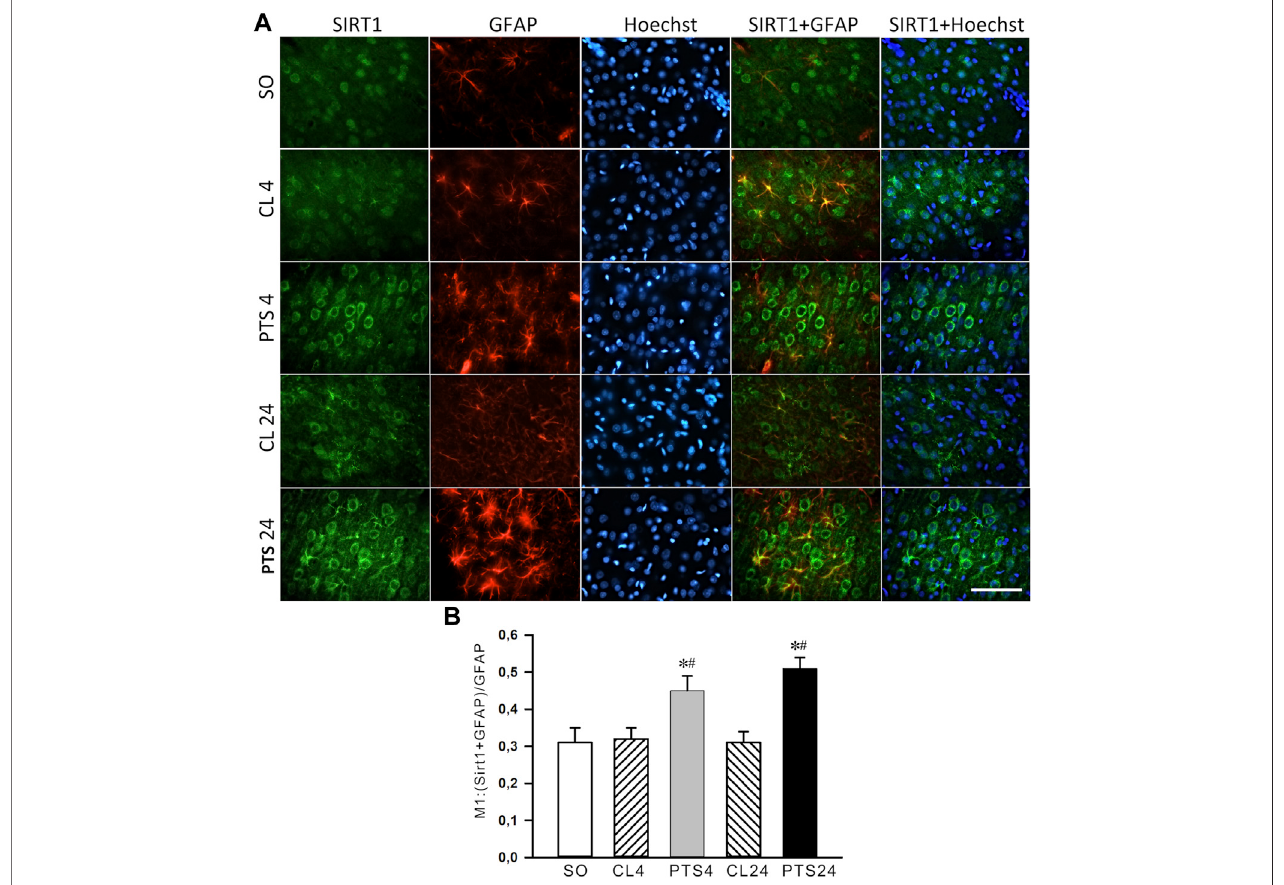
FIGURE3| SIRT1levelsintheastrocytesofischemicpenumbra 4and24 hafterphotothromboticstrokeintheratcerebralcortex(PTS4andPTS24,respectively) compared to the same animals ’ contralateral cortex (CL4 and CL24), or the cortexof sham-operated animals(SO). (A) Immuno fl uorescence ofSIRT1 (green), marker of astrocytes GFAP (red), nuclear chromatin marker Hoechst 33342 (blue), and image overlay. The scale bar is 100 μ m. (B) Coef fi cient M1 of SIRT1 co-localization with astrocyte marker (GFAP) in different control and experimental groups. One Way ANOVA; M ± SEM; n = 7.